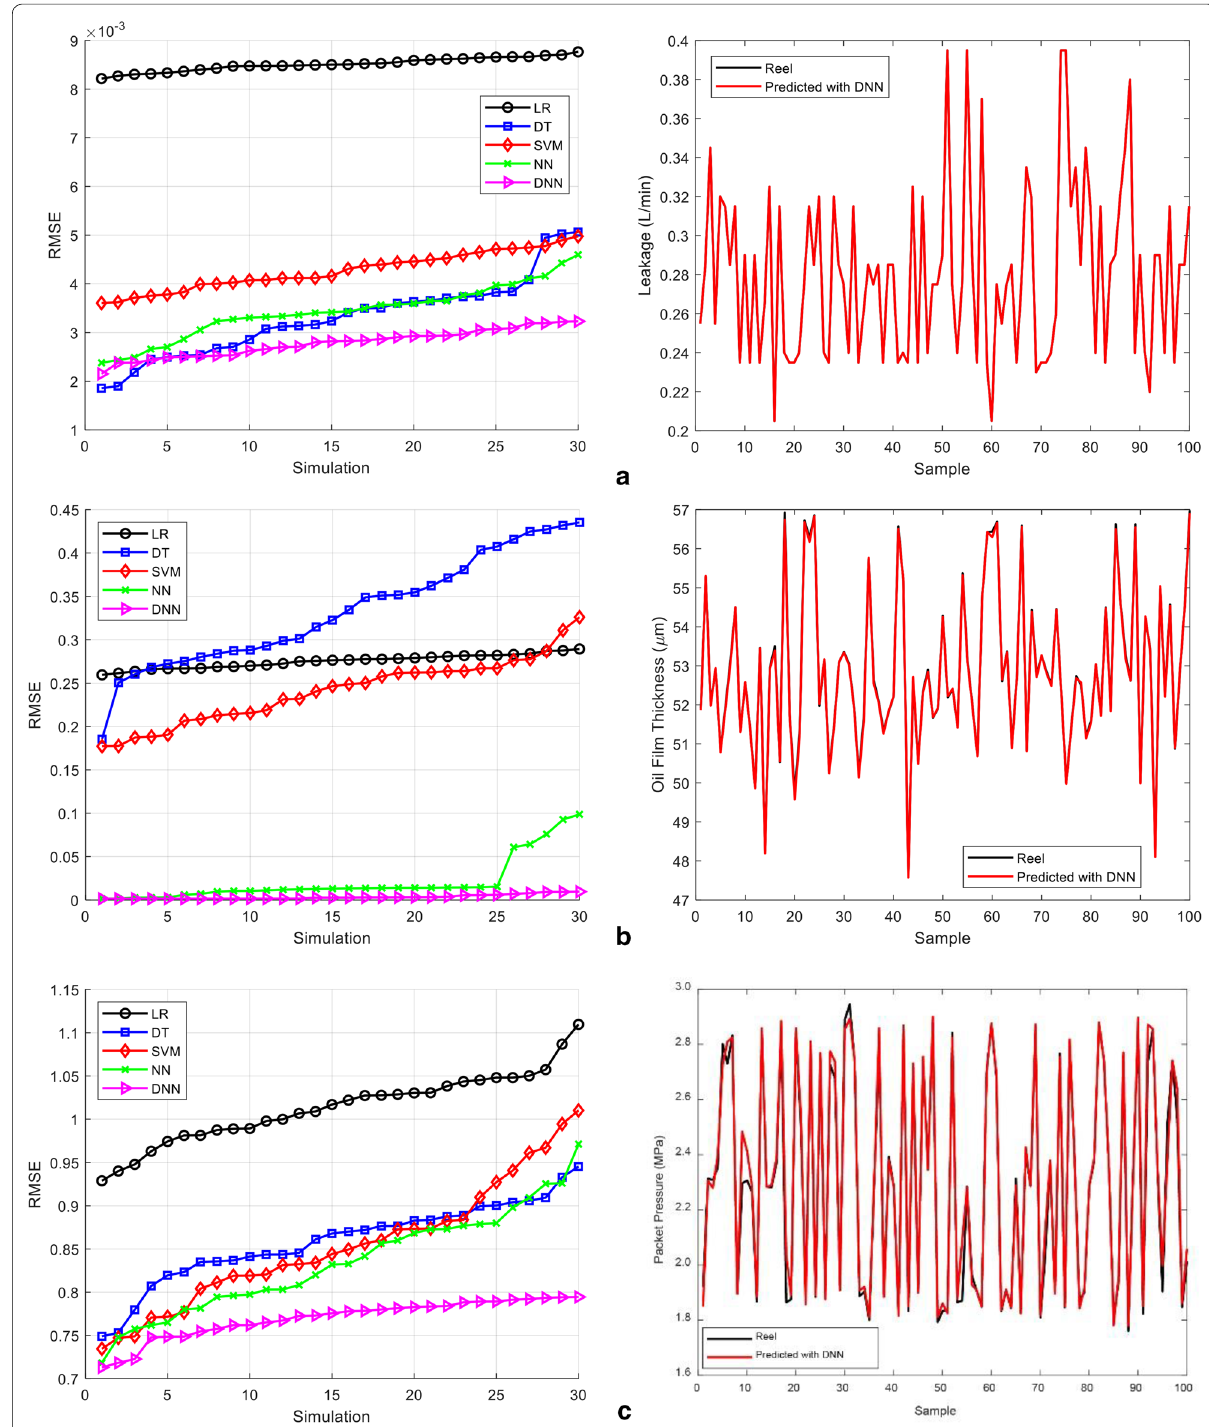
Figure 10 Comparison of MLMs for a leakage, b oil film thickness, and c pocket